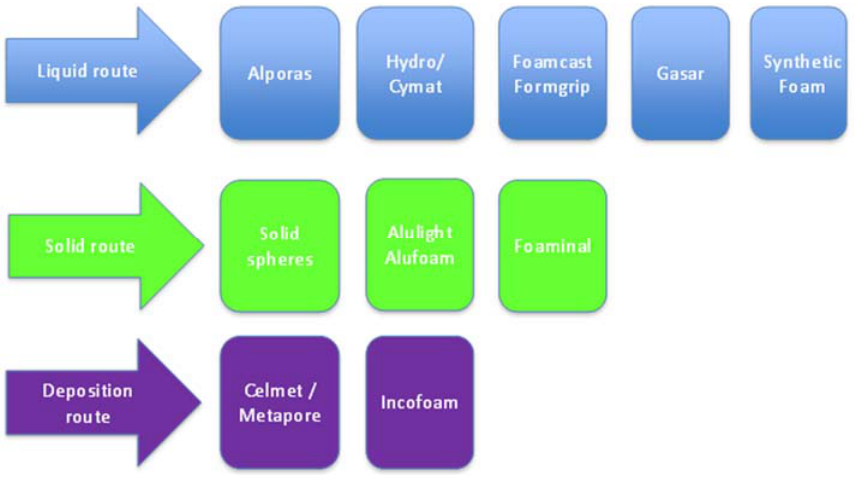
Figure 1. Some of the most employed processes to produce aluminium foams.